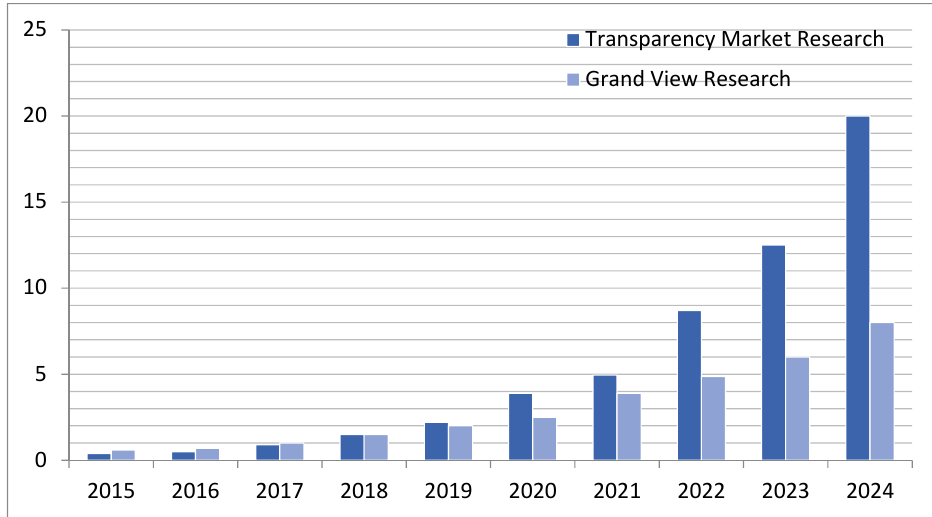
Figure 1. Blockchain market growth dynamics.